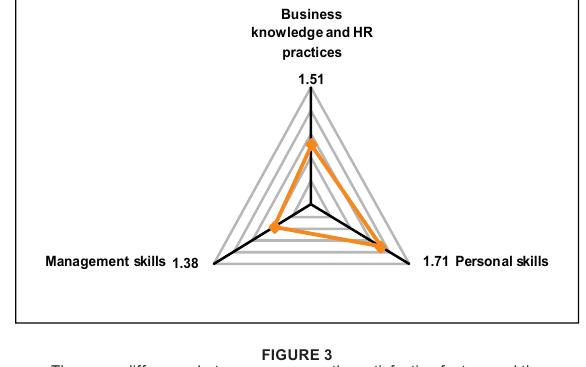
FiguRE 3 The mean difference between scores on the satisfaction factors and the importance factors